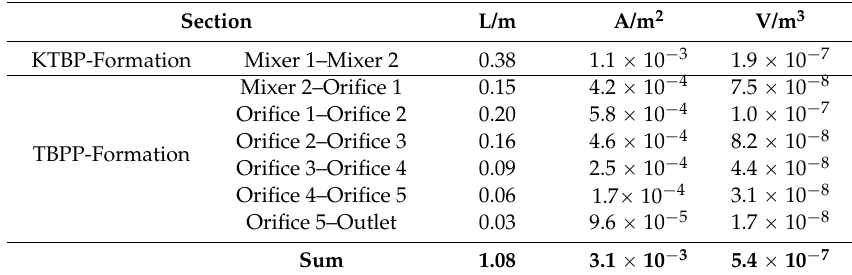
Table 1. Channel lengths, surface areas and channel volumes realized in the orifice microreactor, calculated for a quadratic channel.